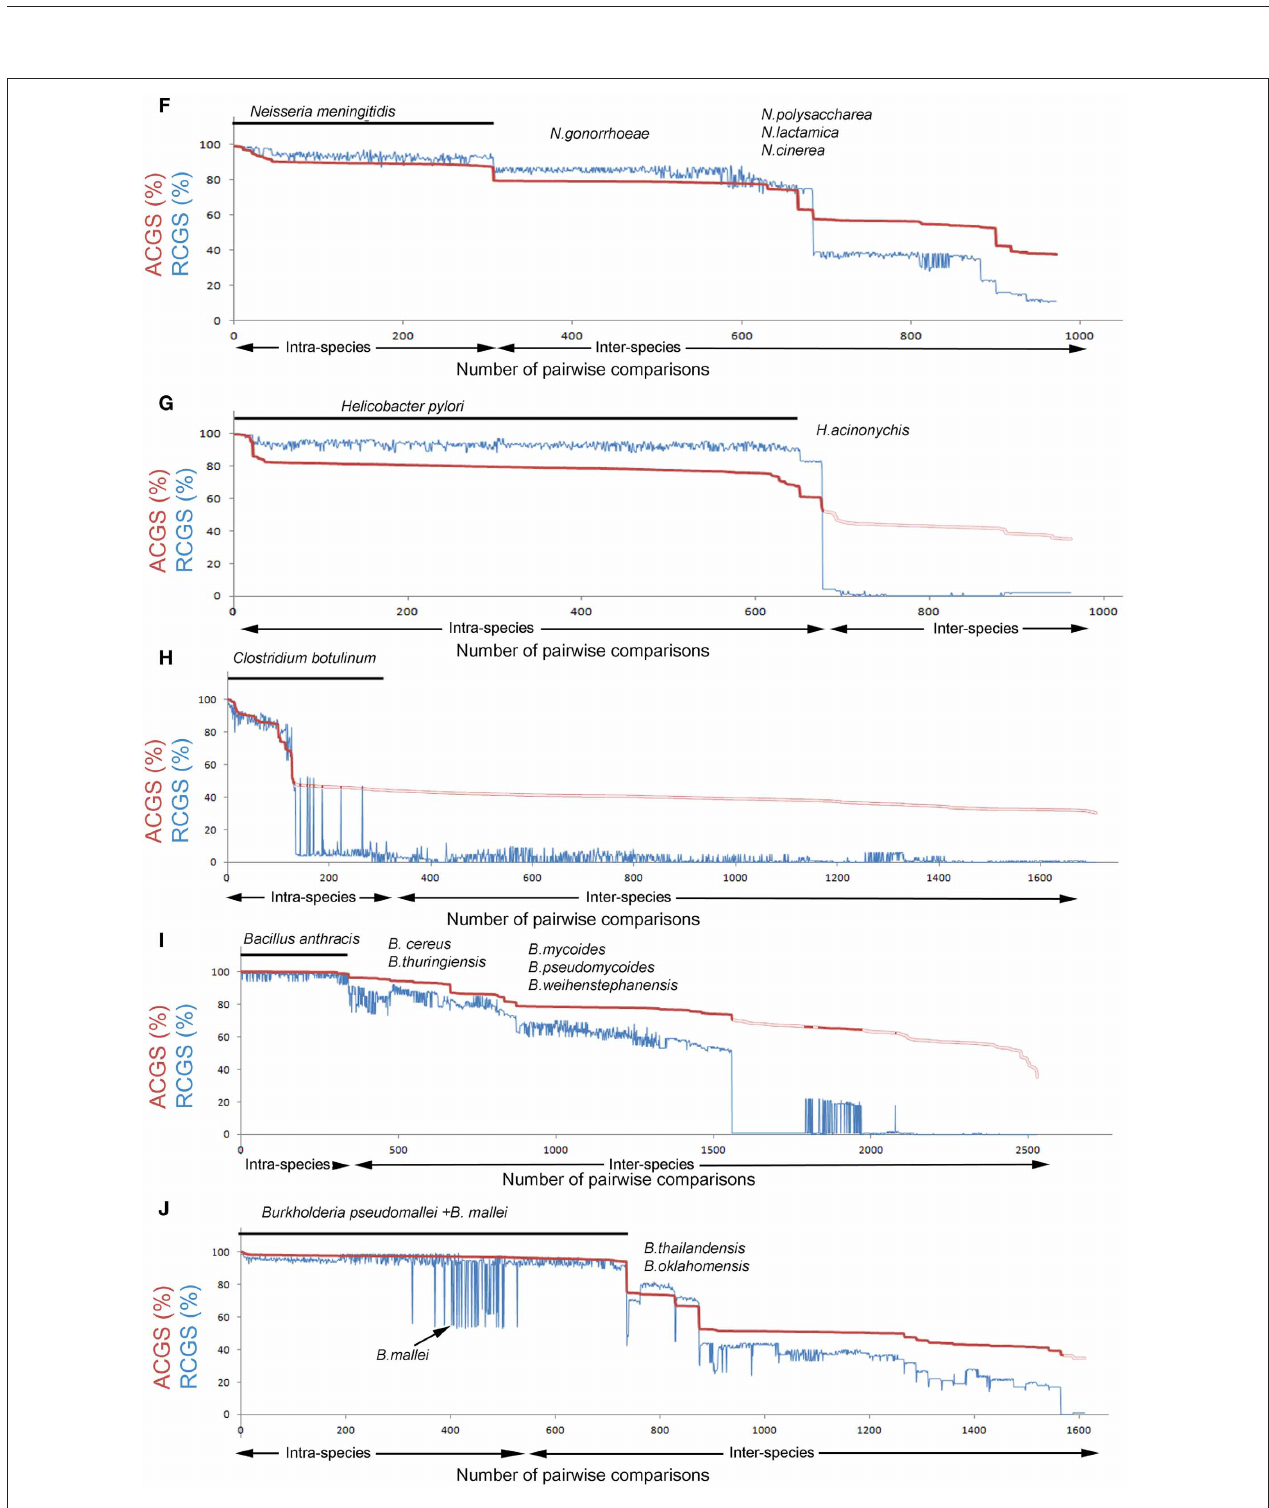
FIGURE 2 | Species integrity diagrams for 10 selected species. Pairwise genome comparisons defining average core genome similarity (ACGS) are shown in red and relative core genome size (RCGS) in blue. ACGS measures phylogenomic distance while RCGS measures the size of the core genome relative to the total genome size (core + accessory genome). Intra-species comparisons are plotted first (indicated with the black line) and inter-species comparisons thereafter. Data are sorted by